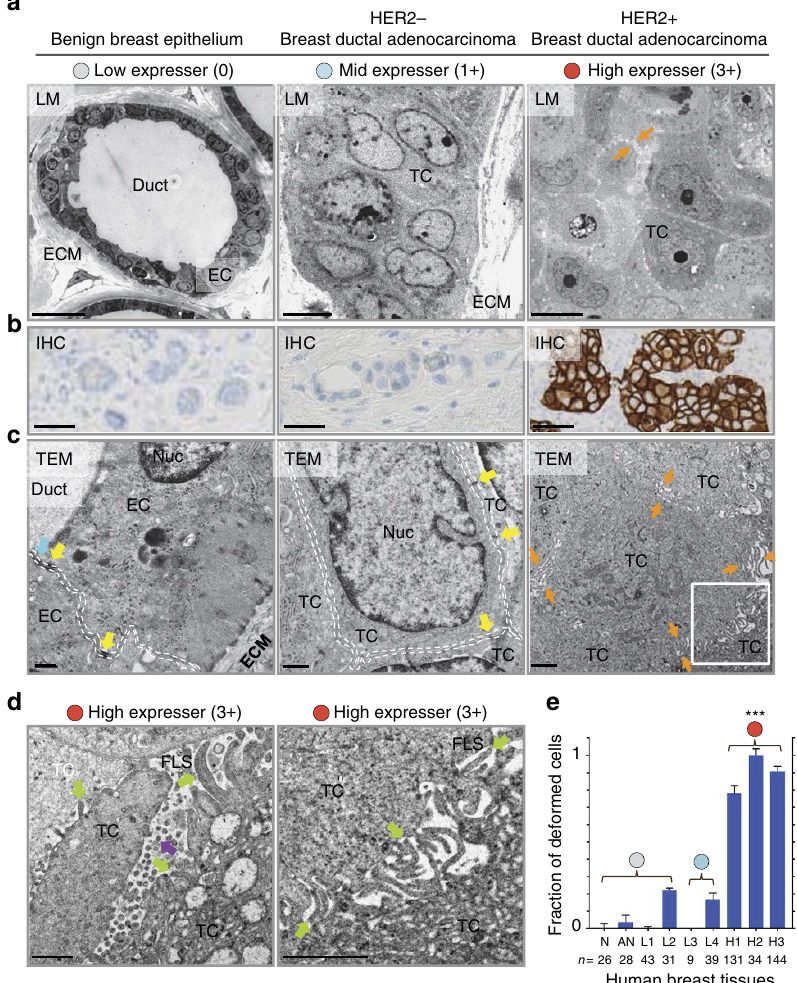
Figure 4 | Membrane deformation occurs in HER2 3 þ human breast tumours. ( a – c ) Human benign breast epithelium (left), HER2 1 þ (middle) and HER2 3 þ breast ductal adenocarcinoma (right) are shown in ( a ) T-blue stained light microscopy (LM; Scale bars, 20 m m (left) and 5 m m (middle and right)), ( b ) HER2 IHC (scale bars, 40 m m) and ( c ) TEM images (scale bars, 0.5 m m (left and middle) and 2 m m (right)). The TEM images show representative cell morphologies. Tight junctions (cyan arrow), desmosomes (yellow arrows), well-defined cell interfaces (between two white dashed lines), and separation of cells (between two orange arrows) are identified. ( d ) TEM images of two different areas in the HER2 3 þ sample. The image on the right is the magnified image of the area in the white rectangle in c . Some of the FLS and circular structures are indicated by green and violet arrows, respectively. Scale bars, 1 m m. ( e ) Fractions of deformed cells (mean ± s.e.m.) were assessed in a blinded manner. The specimens were from one normal (N), one adjacent normal (AN), four HER2 1 þ (L1-L4) and three HER2 3 þ (H1-H3) human tissue samples. The fraction was significantly higher in 3 þ samples. *** P value o 10 (cid:3) 6 by two-sided, unpaired Welch’s t -test. EC, epithelial cell; ECM, extracellular matrix; Nuc, nucleus; TC, tumour